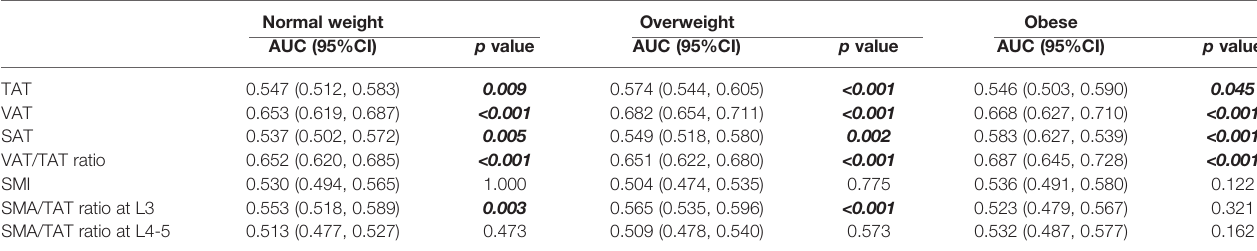
TABLE 3 | ROC curves of indices of body composition for metabolically unhealthy. Normal weight Overweight